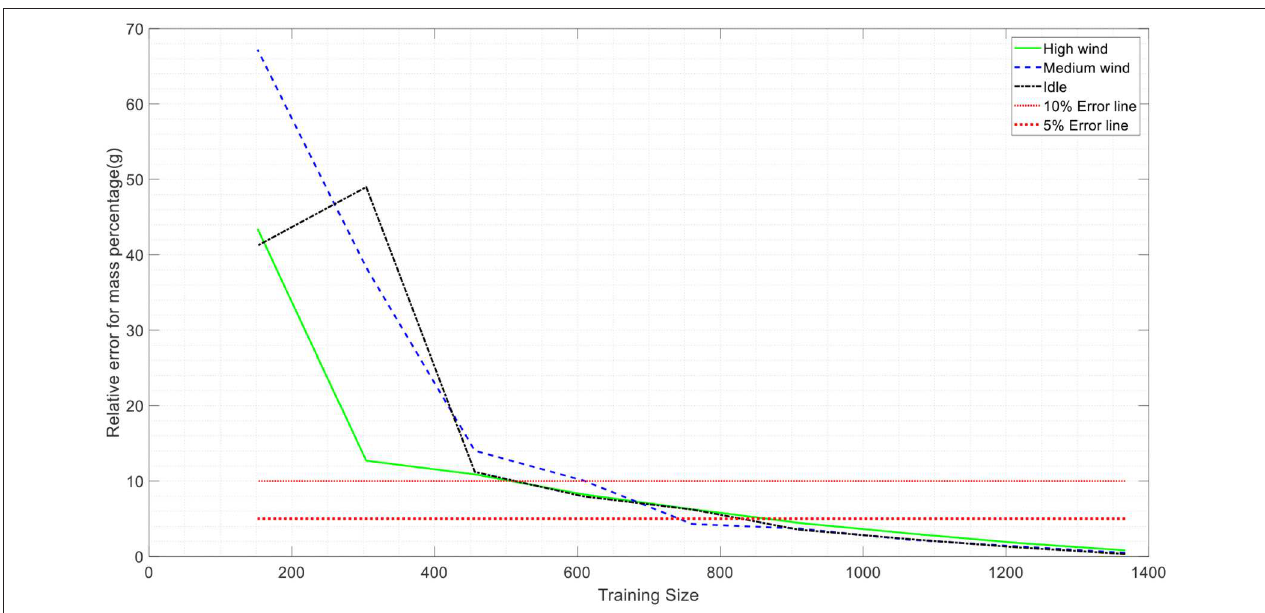
FIGURE 7 | Variation prediction of mean values for firebrand mass with sample size.